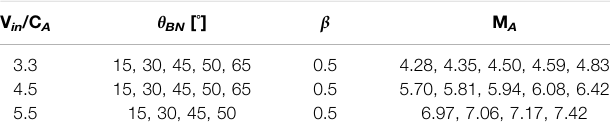
TABLE 1 | In fl ow velocities, θ BN angles and the resulting Alfvénic Mach numbers (M A ) for the 15